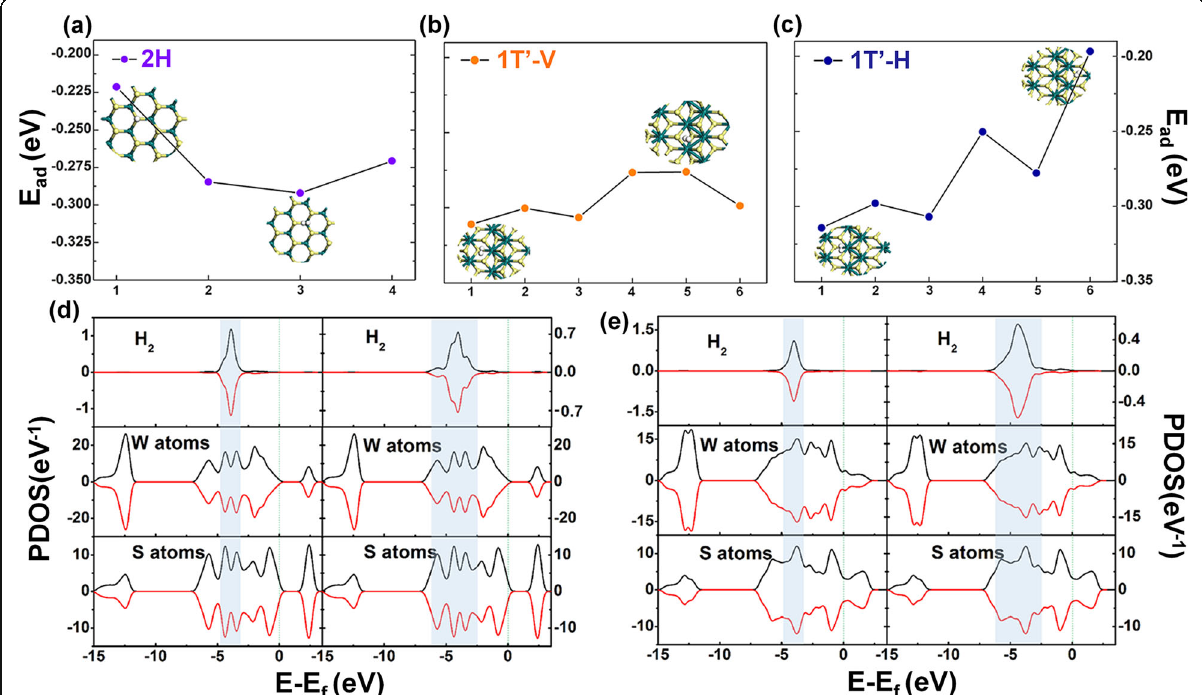
Fig. 2 Adsorption energy results of H 2 adsorption system for a single H 2 on 2H-WS2, b and c single H 2 on 1T ’ -WS 2 ; PDOS results of the situation with thelowest (left) or the highest (right) E ad in d 2H models and that in e 1T ’